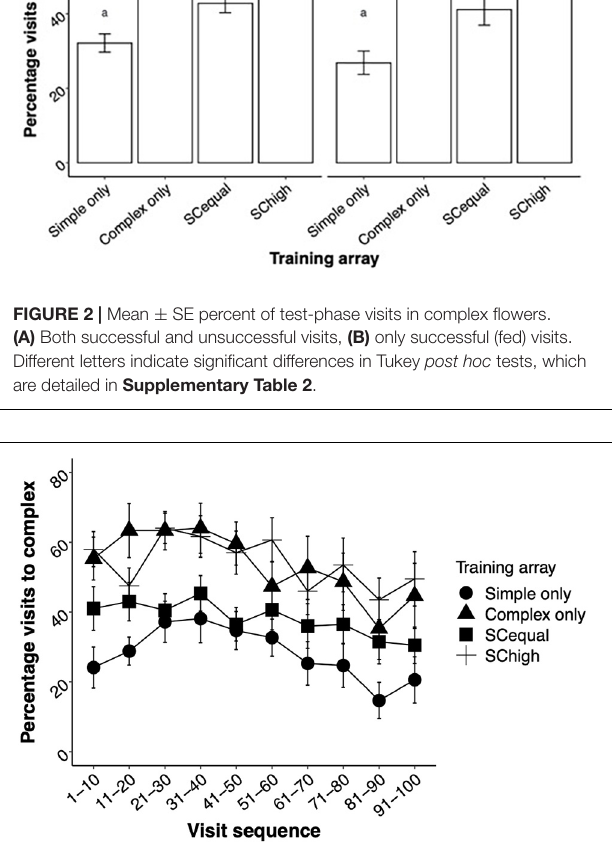
affected run lengths in the test phase ( χ 2 = 16.55, df =